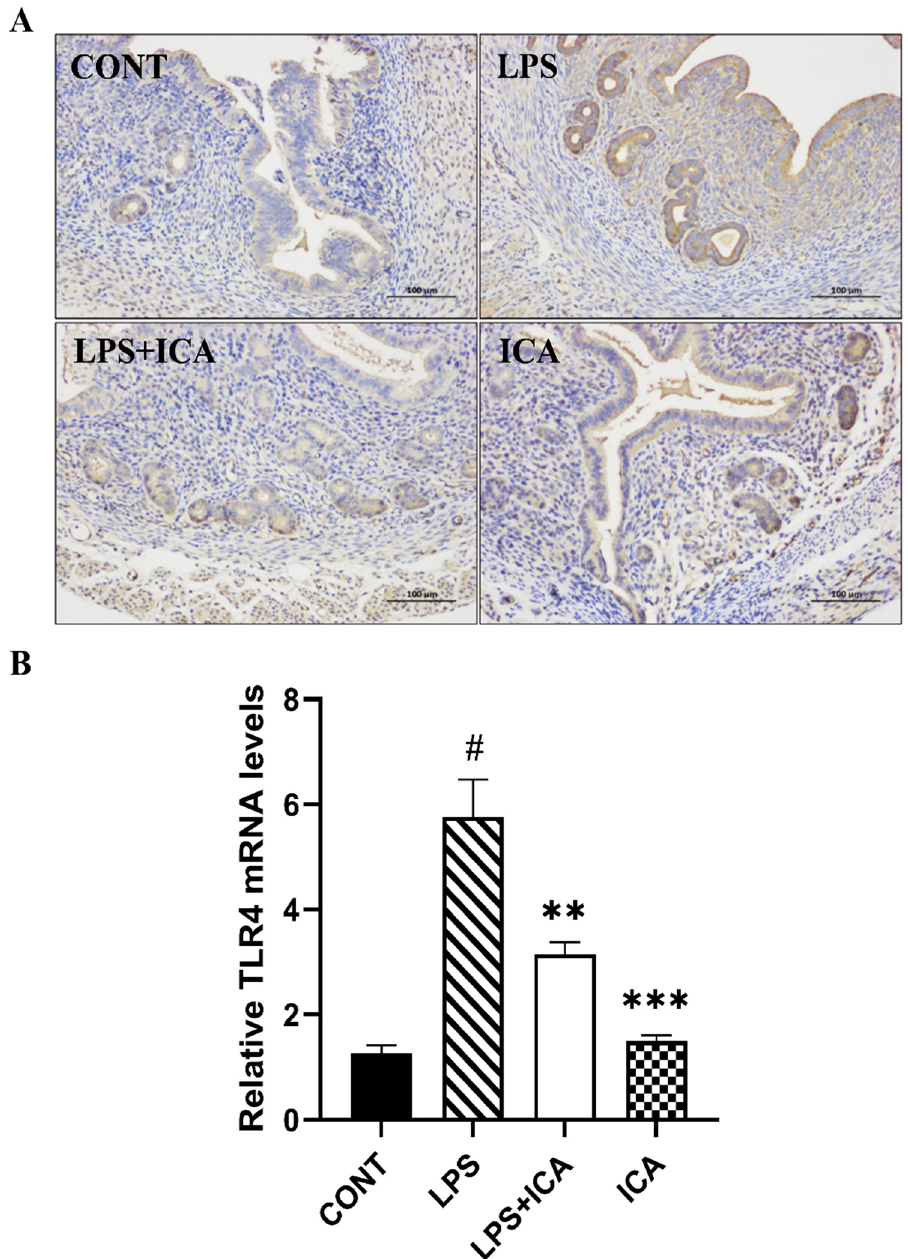
Figure 4. Consequences of ICA on LPS-induced TLR4 expression. ( A ) The immunohistochemical expression of TLR4 protein. ( B ) The relative mRNA expression level of the TLR4 gene. The data were statistically presented as means ± SEM. The # p < 0.001 between CONT and LPS groups, and ** p < 0.01, *** p < 0.001 between LPS and ICA therapy groups. (CONT, LPS and ICA stand for control, lipopolysaccharide and Icariin groups [The ICA dose used was 50 mg/kg for uterine